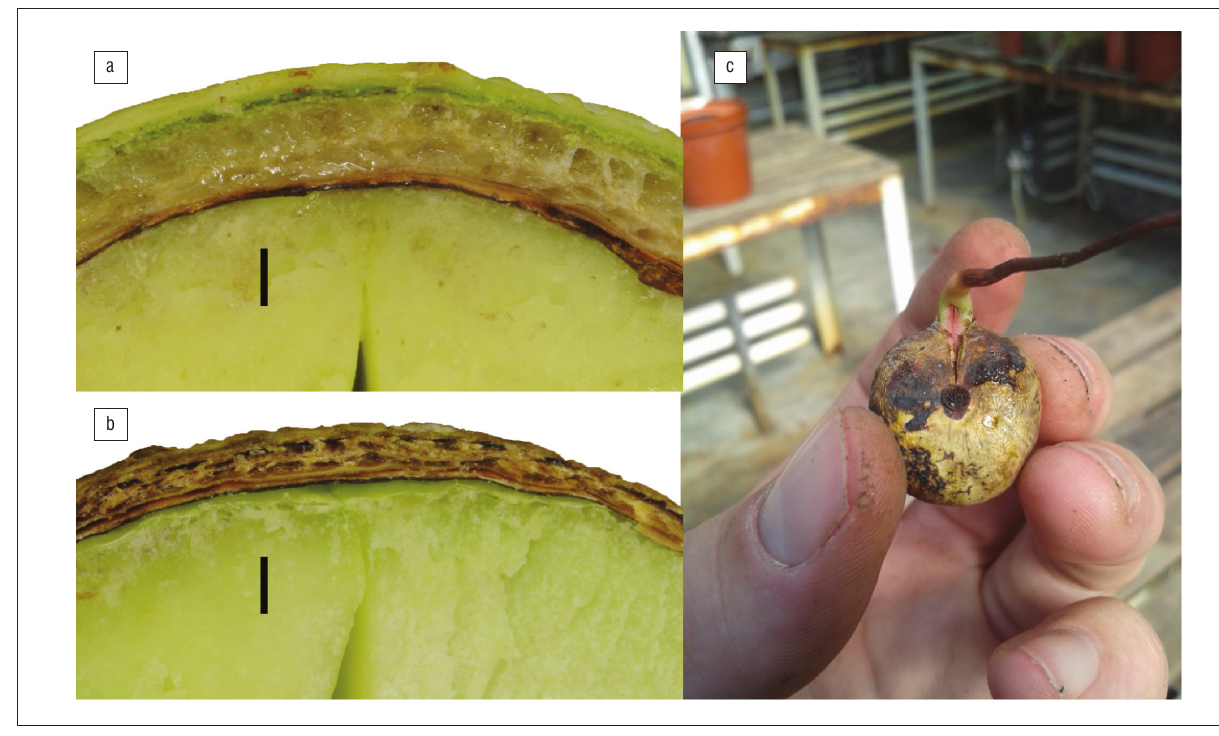
Figure 2: Cross-section of Heeria argentea fruits that are (a) intact and (b) with the pericarp removed showing the fleshy layer that Namaqua rock rats consume. (c) A germinated seed with the radicle breaking through a fruit without the leathery pericarp.